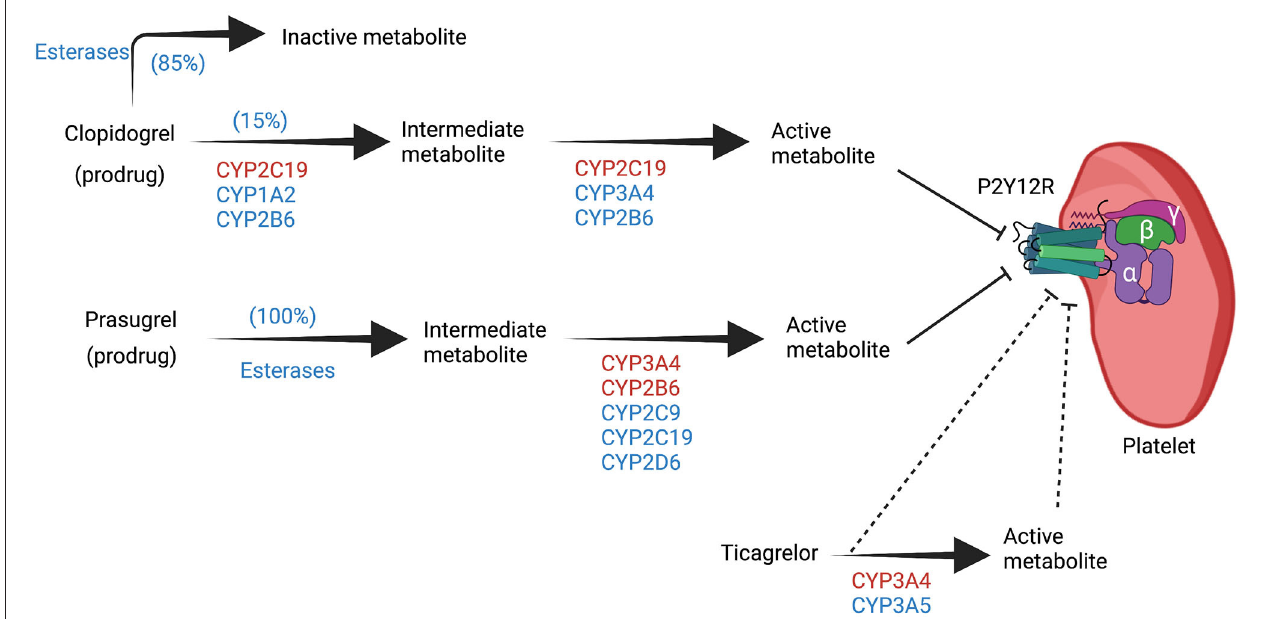
FIGURE 1 | Overview of the biotransformation of P2Y12 inhibitors. Clopidogrel and prasugrel are prodrugs that require bioactivation via cytochrome P450 (CYP) to their active metabolite that can inhibit the P2Y12 receptor in a competitive manner. The two steps of bioactivation of clopidogrel are CYP dependent, while only one step of prasugrel bioactivation is CYP dependent. Ticagrelor undergoes biotransformation to another metabolite via CYP but both ticagrelor and its metabolite can inhibit the P2Y12 receptor in a non-competitive manner. CYP enzymes highlighted in red have more significant roles in each of the steps. Created with